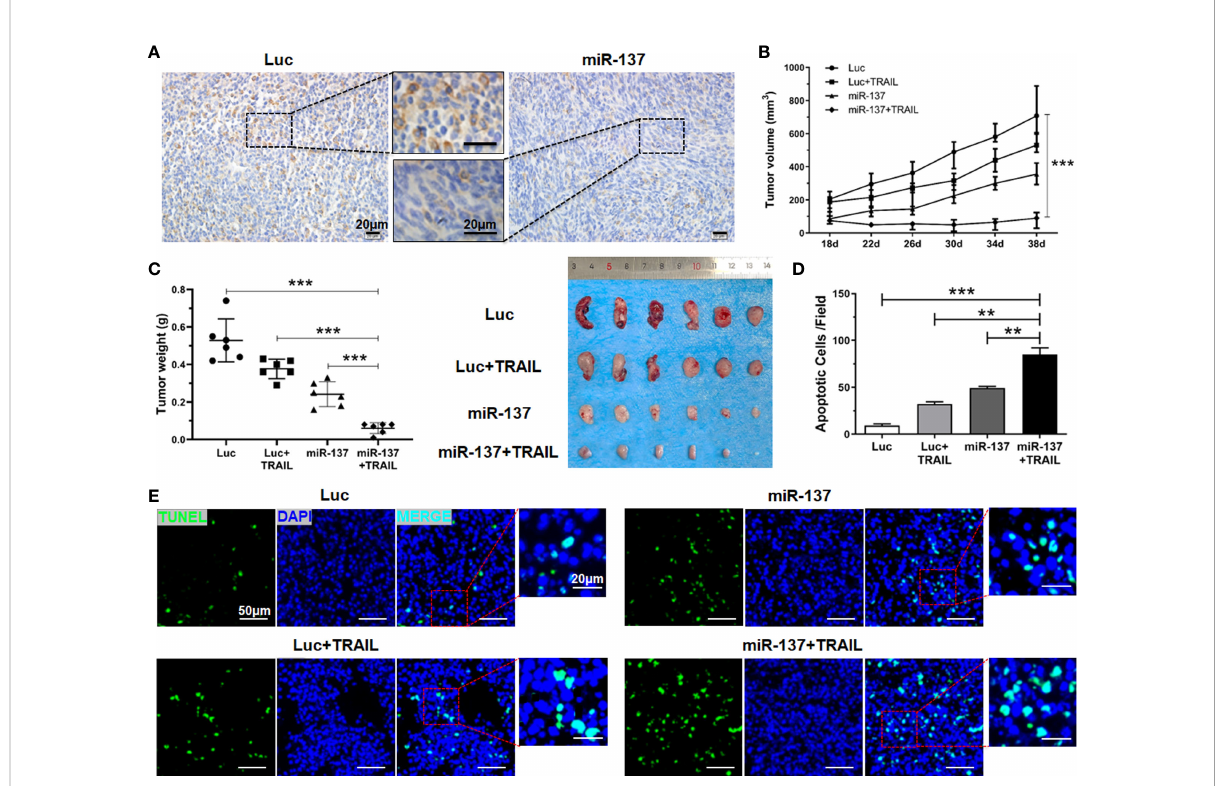
FIGURE 7 miR-137 cooperating with TRAIL suppressed tumor growth in nude mice. (A) IHC analysis depicting the changes of XIAP expression level in excised tumors using anti-XIAP antibody, with scale bars = 20 µm. (B) Graphical representation of the changes in the tumor volume followed by subcutaneous injection of pLenti6.3-Luciferase/TRAIL plasmid for a period of 3 weeks (n = 6 per group). (C) Tumor weight of the excised tumors from the different treatment sets (left panel), representative appearance of tumor mass resected from each group of mice (right panel). (D) TUNEL staining assay showing the apoptotic cells of the excised tumors in each group. [Apoptotic cells were averaged in six random fi elds each group]. (** P < 0.01, *** P < 0.001.) (E) Representative fi elds of cell apoptosis, with scale bars = 20 µm or 50